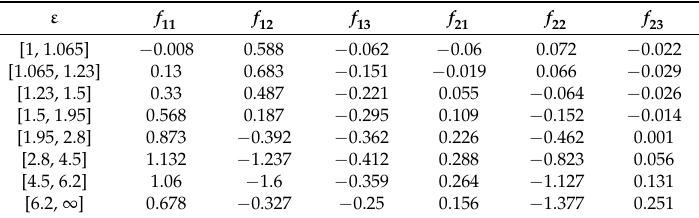
Table 1. Perez model coefficients for various values of clearness ε